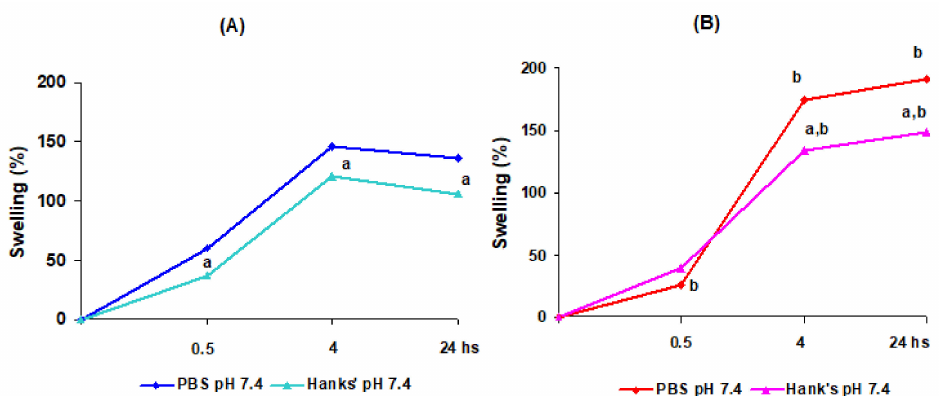
Figure 5. Swelling degree of AP4 ( A ) and HS4 ( B ) gel beads incubating in PBS at pH 7.4 and Hanks’ solution (pH 7.4) for 24 h. The data are presented as the mean (n = 10). a p < 0.05 vs. PBS pH 7.4; b p < 0.05 vs. the corresponding AP4 gel